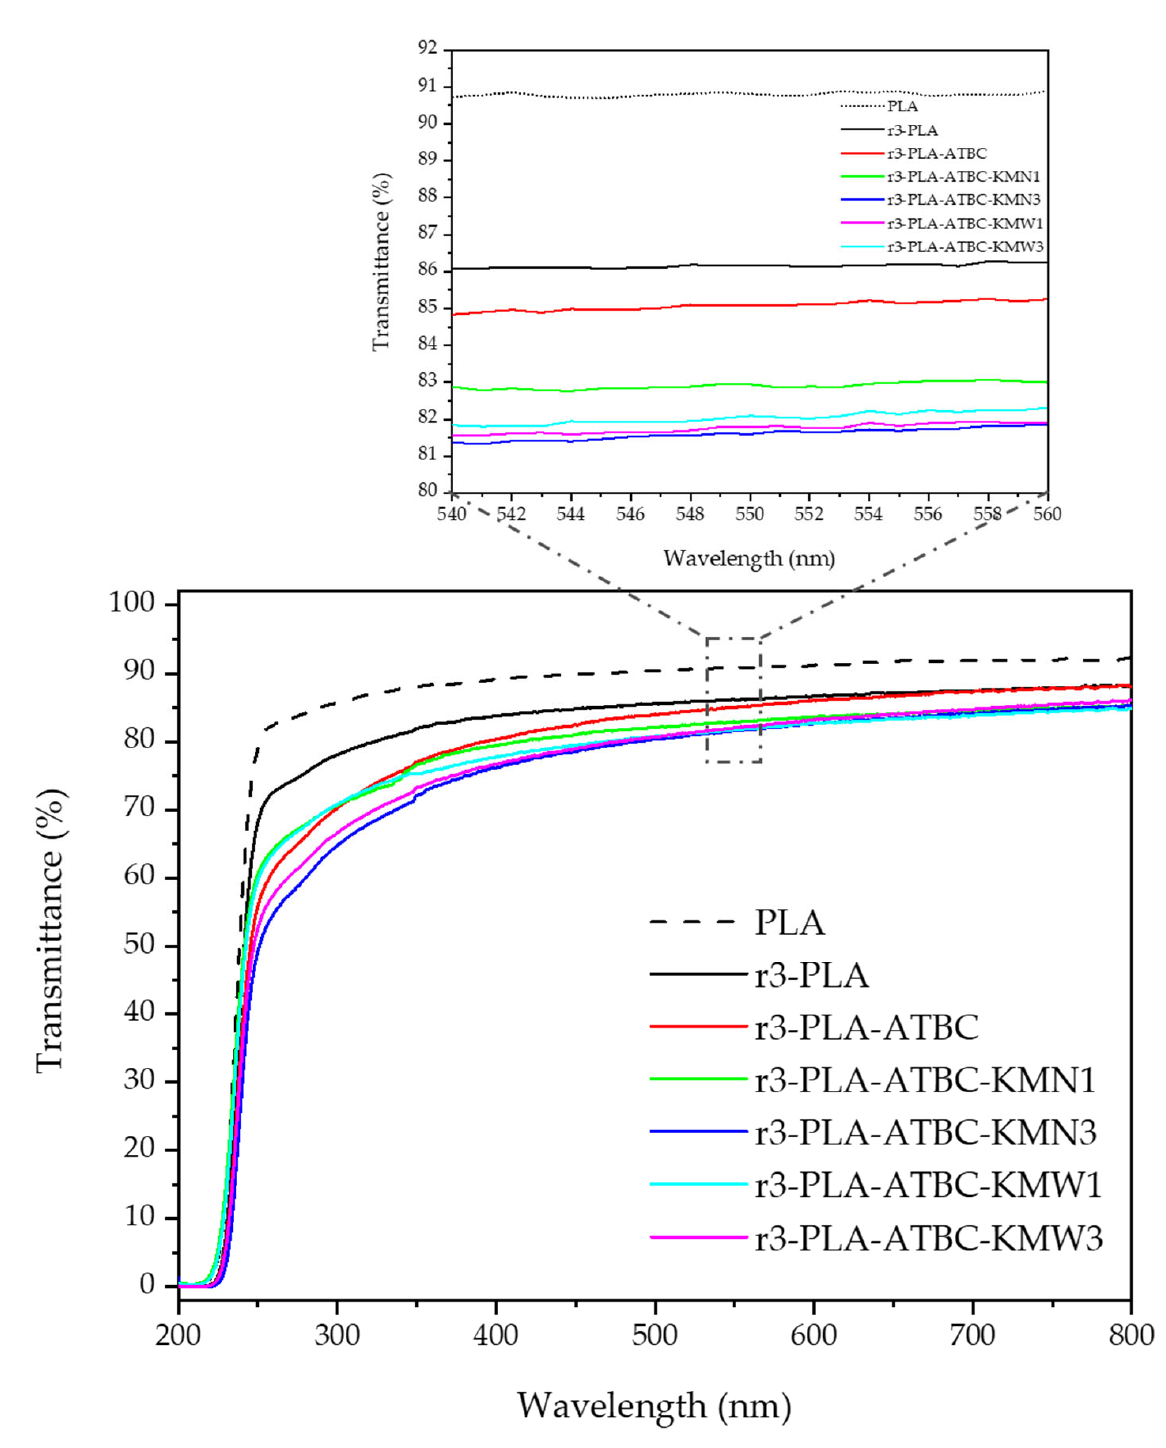
Figure 2. UV ‐ vis spectra of films 200–800 nm and zoom image 540–560 nm. Figure 2. UV-vis spectra of films 200–800 nm and zoom image 540–560